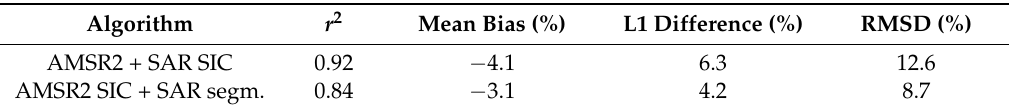
Table 5. Validation statistics for the sea ice concentration estimation using the SENTINEL-1 SAR and AMSR2 radiometer data and two different algorithms: AMSR2 + SAR SIC and AMSR2 SIC + SAR segm. Sea ice concentration validation data retrieved from the MODIS SIT charts for November 2015 to April 2016.